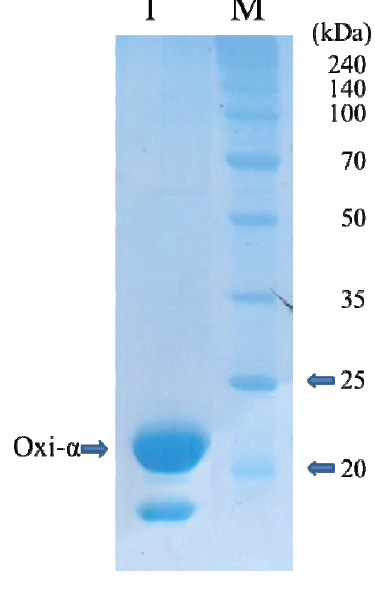
Figure 1. Coomassie-stained SDS-PAGE (12%) of C165S mutant Oxi- α . Lane 1,